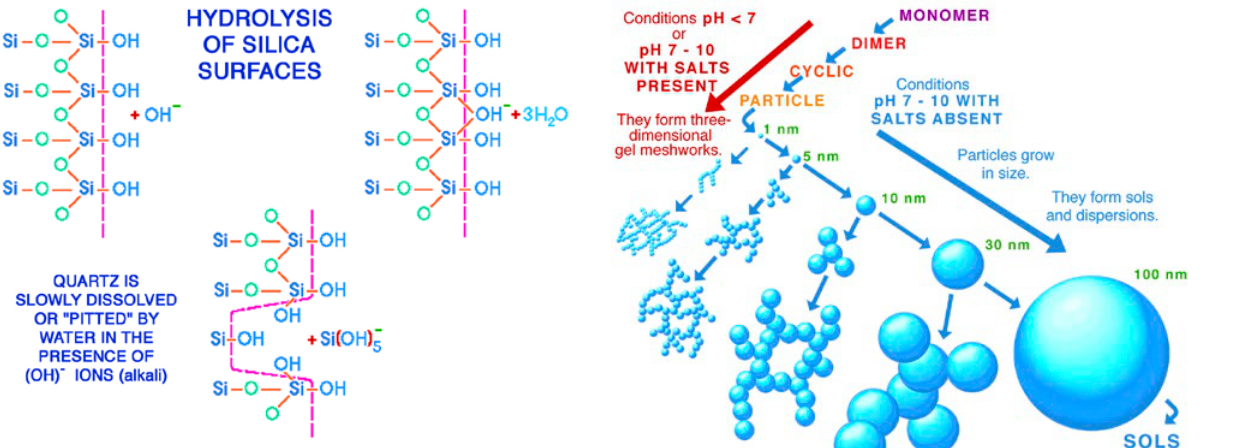
Figure 45. The dispersion of solid silica in water is catalysed by hydroxyl ions such as an alkali or base. Seawater is slightly alkaline and therefore silica (and most silicate) surfaces “dissolve” by these surface reactions. (Redrawn from Iler 8 , 1979, fig. 1.11.)